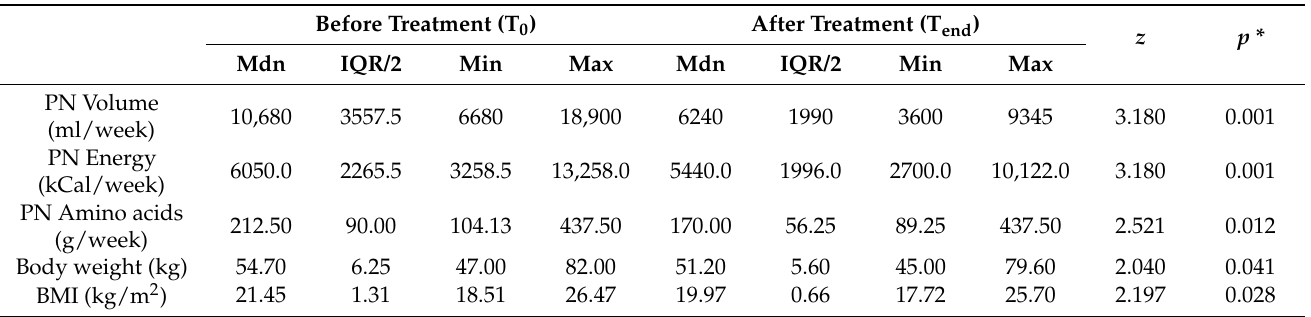
Table 2. Comparison of parenteral nutrition (PN) requirements and anthropometric measures before and after teduglutide